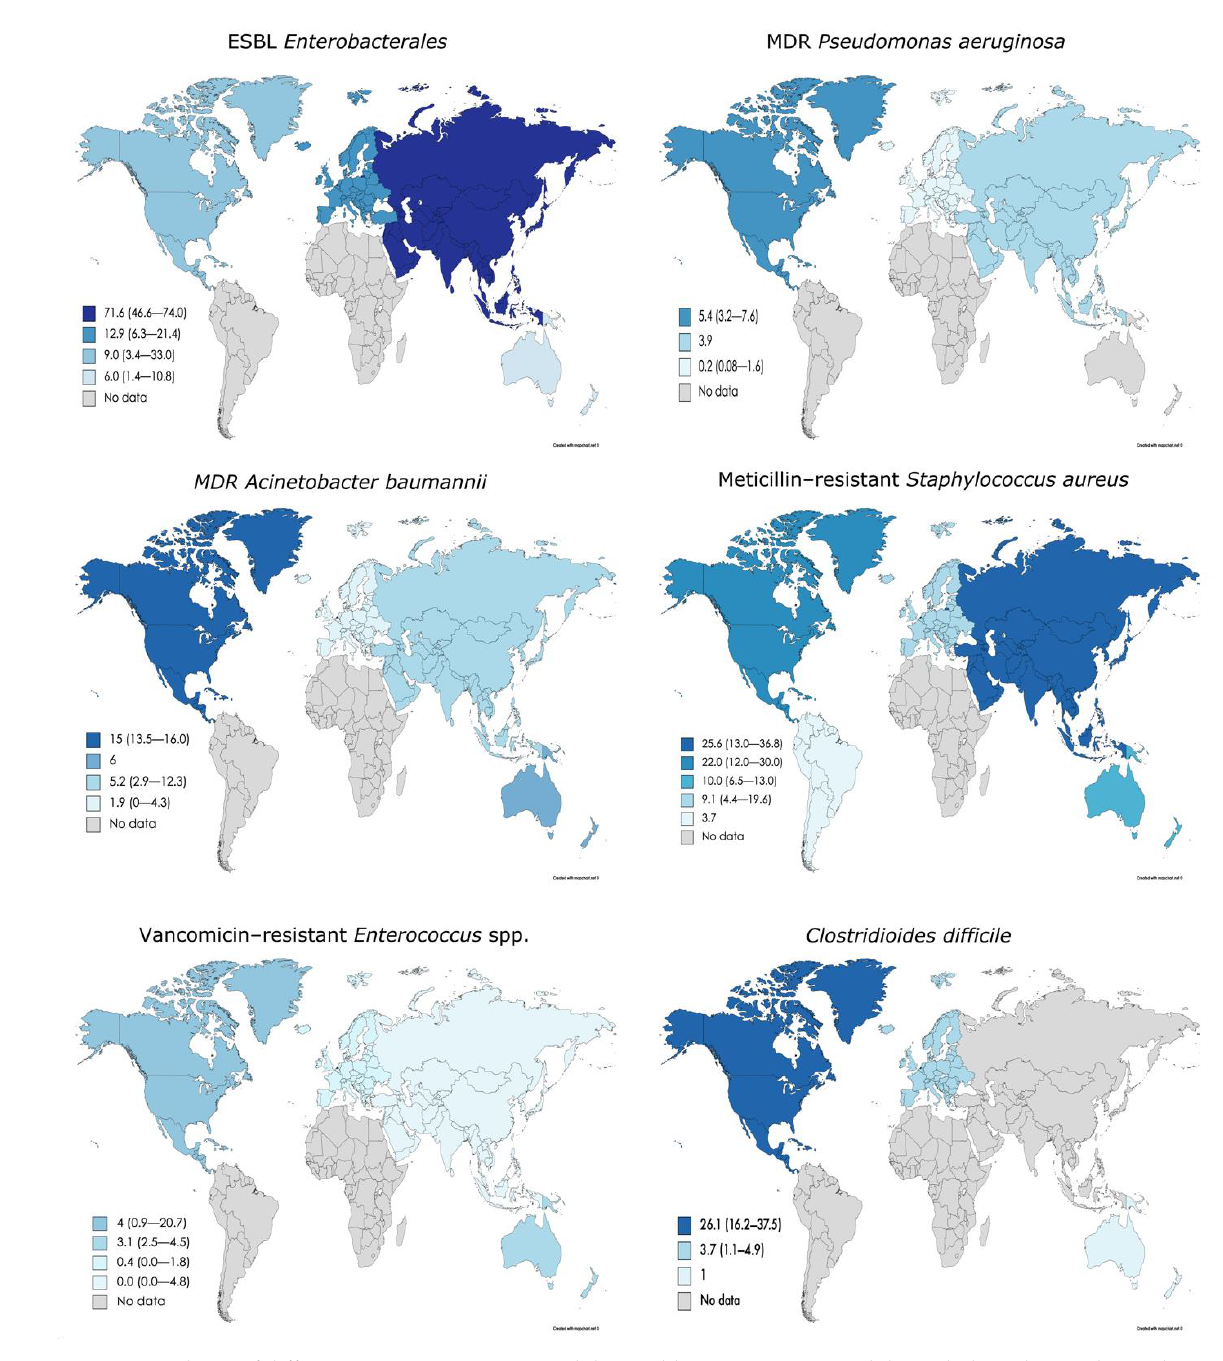
Figure 2. Prevalence of different MDRO in LTCF around the world. Maps were created through the online tool Mapchart.net (https://mapchart.net/world.html, accessed on 23 November 2020). ESBL, extended-spectrum ß-lactamase; MDR, multidrug-resistant.